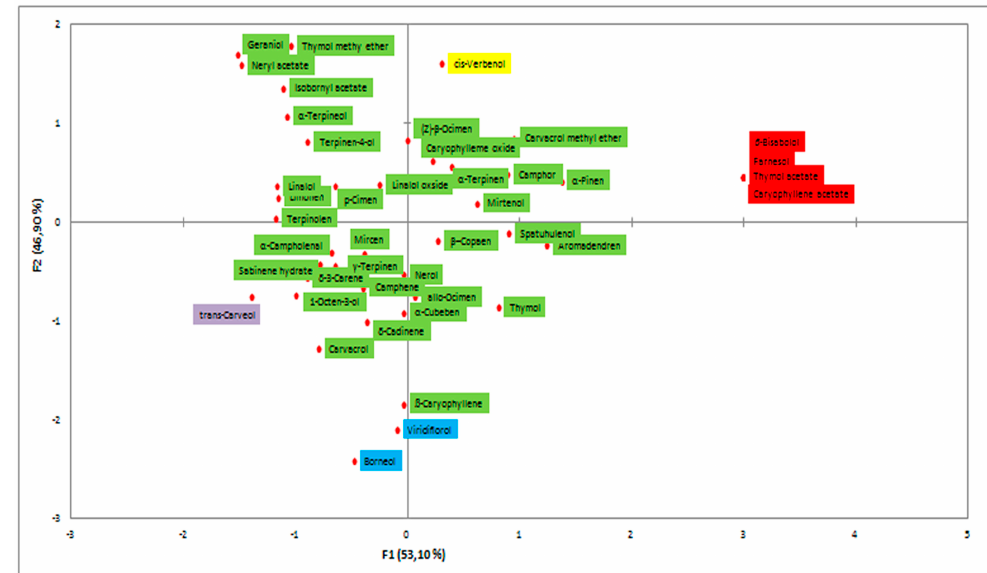
Figure 1. PCA of essential oil (EO) components in Micromeria croatica from the localities Bojinac (Boj), Ba č i ć kuk (Bk) and Stupa č inovo (St).